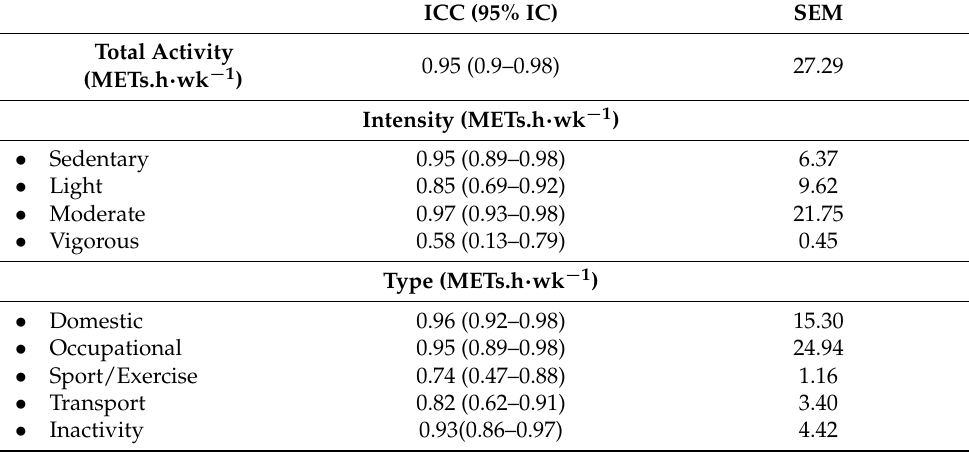
Table 4. Reliability of the PPAQ—intraclass correlation coefficient (ICC) and the standard measure- ment error (SEM) between PPAQ1 and PPAQ2 (n = 31).